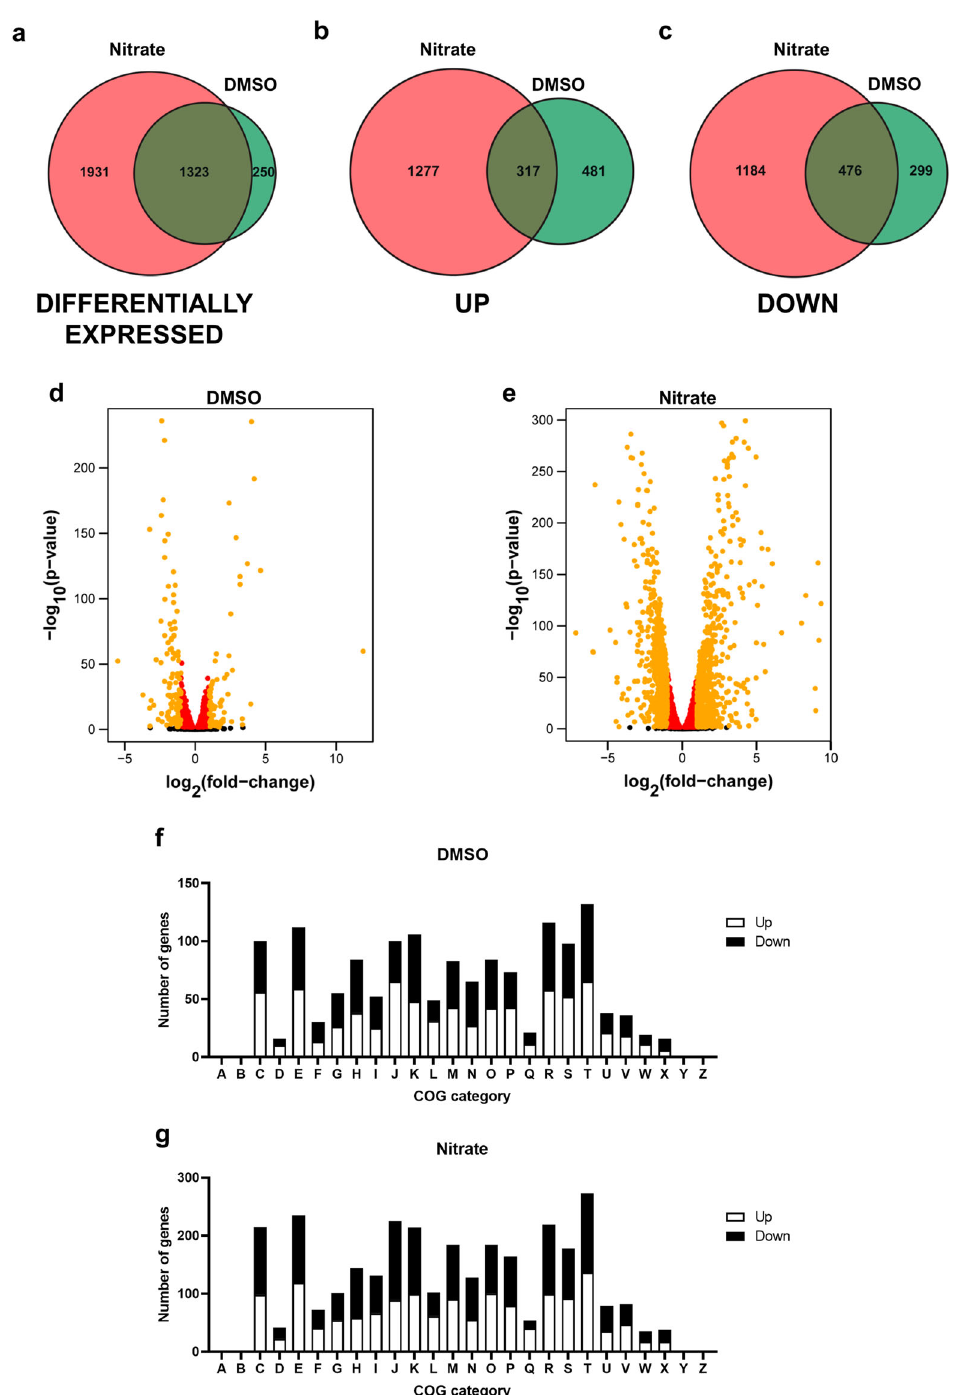
Fig. 6 Transcriptomic pro fi les of S. algae CECT 5071 static cultures supplemented with DMSO or nitrate. Venn diagrams of ( a) differentially expressed genes (P-adj<0.05) in both treatments, ( b) genes with upregulated transcript levels and ( c) genes with downregulated transcript levels. Volcano plots showing alterations in gene transcript levels in static cultures supplemented with 35mM DMSO ( d ) and nitrate ( e ). In red are the genes that are signi fi cantly differentially regulated (P-adj <0.05) with a fold-change value below 2 or above 0.5. In orange are the rest of differentially expressed genes. Black indicates genes not signi fi cantly differentially regulated. COG assignation of differentially expressed genes in S. algae CECT 5071 upon addition of 35mM DMSO ( f ) or sodium nitrate ( g ) versus control cultures without electron acceptor addition. COG categories: [A] RNA processing and modi fi cation; [B] Chromatin structure and dynamics; [C] Energy production and conversion; [D] Cell cycle control, cell division, chromosome partitioning; [E] Amino acid transport and metabolism; [F] Nucleotide transport and metabolism; [G] Carbohydrate transport and metabolism; [H] Coenzyme transport and metabolism; [I] Lipid transport and metabolism; [J] Translation, ribosomal structure and biogenesis; [K] Transcription; [L] Replication, recombination and repair; [M] Cell wall/membrane/envelope biogenesis; [N] Cell motility; [O] Post-translational modi fi cation, protein turnover, and chaperones; [P] Inorganic ion transport and metabolism; [Q] Secondary metabolites biosynthesis, transport, and catabolism; [R] General function prediction only; [S] Function unknown; [T] Signal transduction mechanisms; [U] Intracellular traf fi cking, secretion, and vesicular transport; [V] Defense mechanisms; [W] Extracellular structures; [Y] Nuclear structure; and [Z]